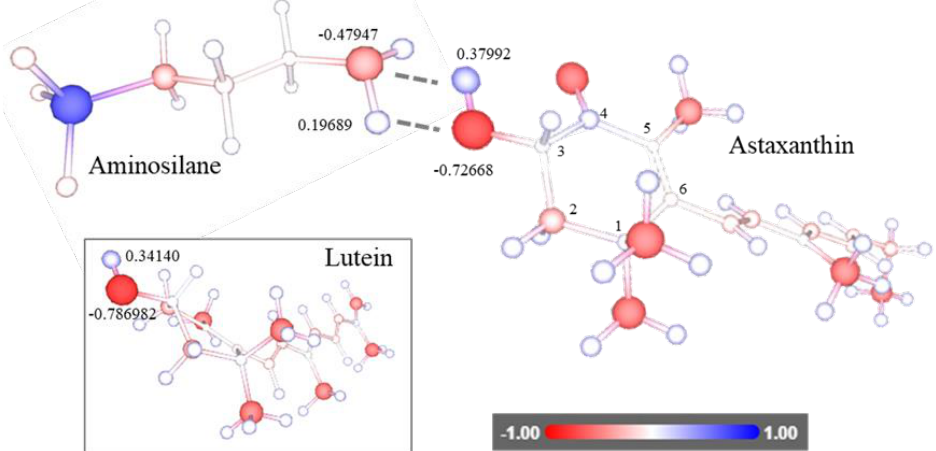
Figure 7. Proposed mechanism for carotenoids binding on aminosilane functionalized magnetic nanoparticles. Dash lines represent hydrogen bonds. Numbers represent the electrical charges of atoms. Electrical charge scale has been normalized with an arbitrary range between -1 (max negative charge) and 1 (max positive charge) using AtomicChargeCalculator software [29]. Red and blue color intensity indicate the charge magnitude.